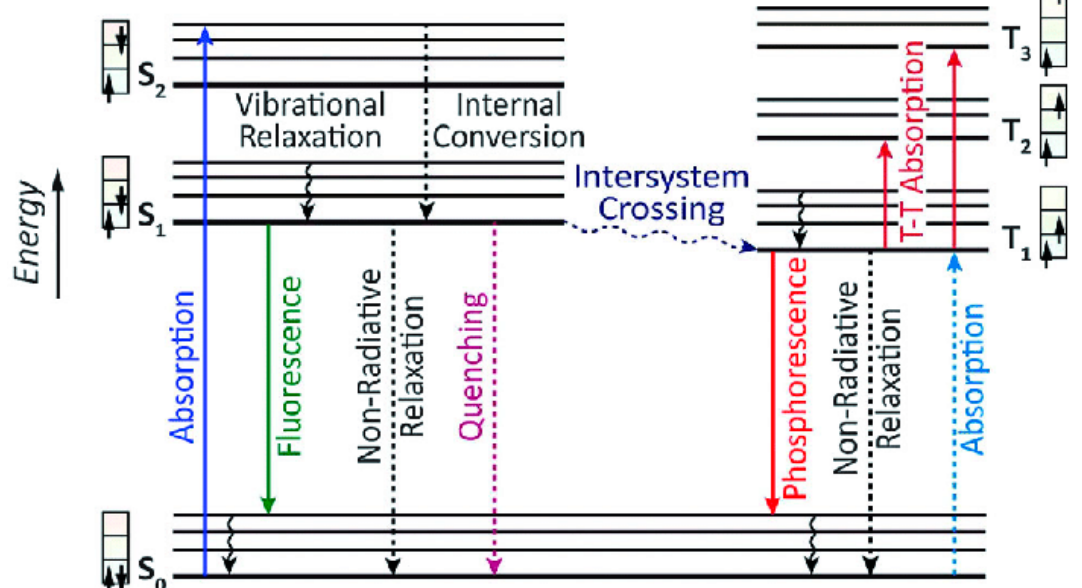
Figure 1. Jablonski diagram showing fluorescence and phosphorescence energy systems where arrows depict ground and excited state processes [30].